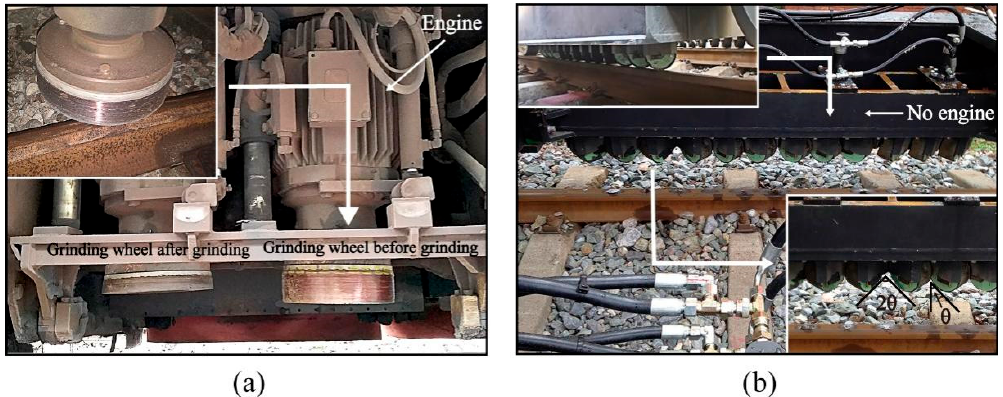
Figure 1. Rail grinding machine, ( a ) active grinding, ( b ) passive